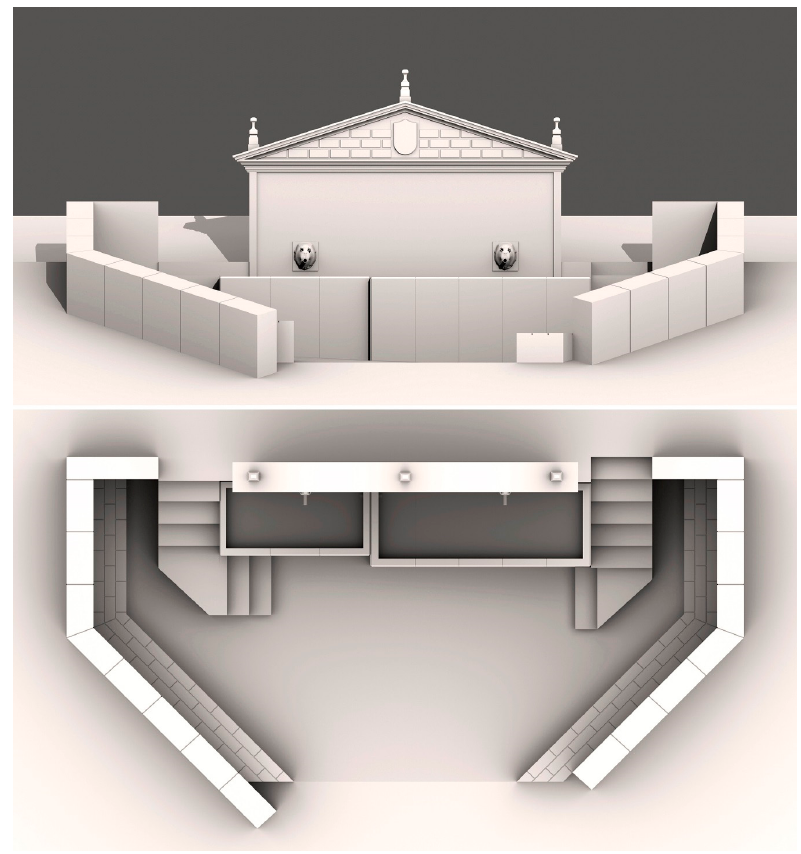
Figure 6. Plan and elevation of the virtual reconstruction of the Porta Miñá Fountain in Lugo. The image was provided by the authors.